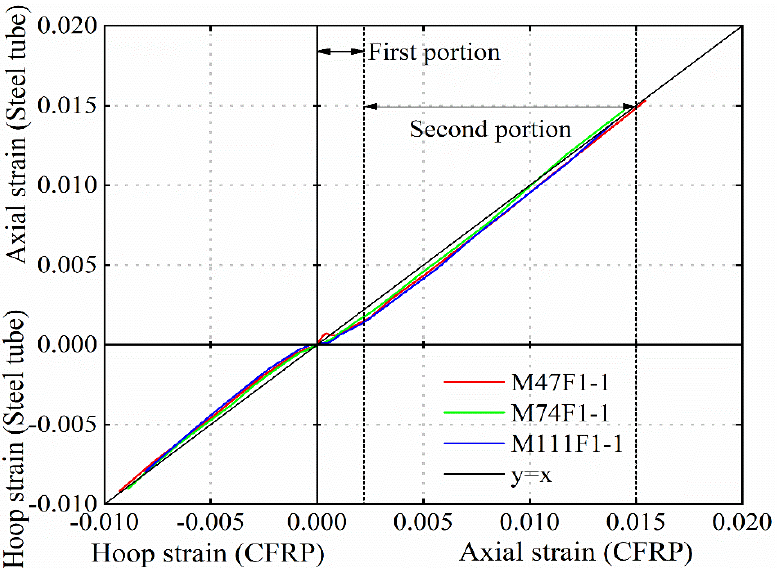
Figure 10. Relative slip of steel tubes and CFRP jackets.